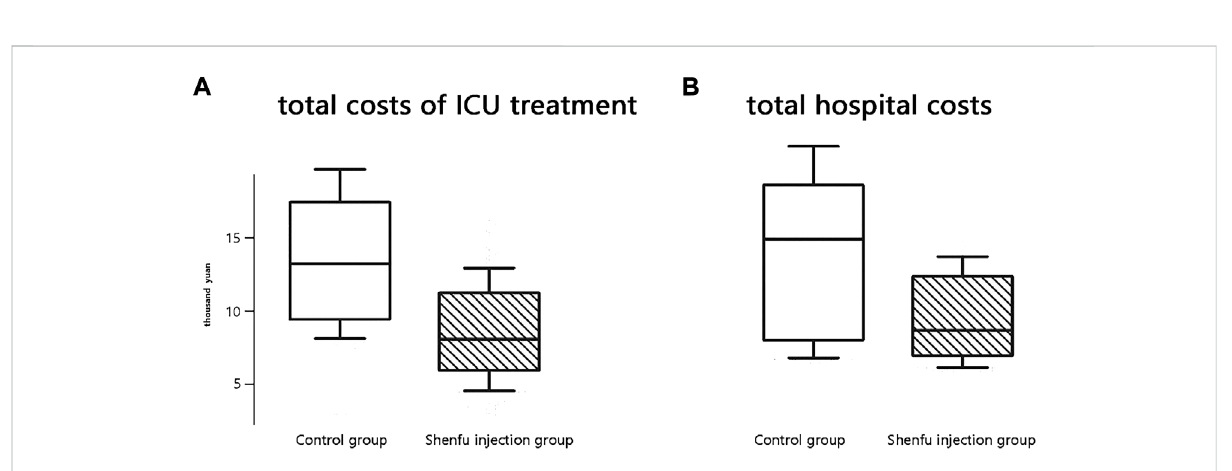
FIGURE 4 Boxplot of costs in two groups. (A) total costs of ICU treatment. (B) total hospital